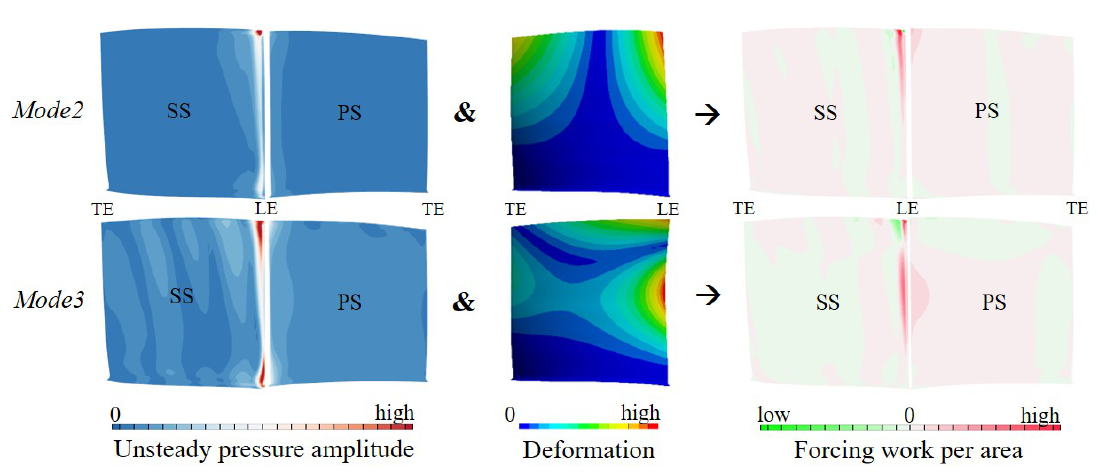
Figure 8. Distribution of unsteady pressure amplitude, eigenmode, and forcing work per